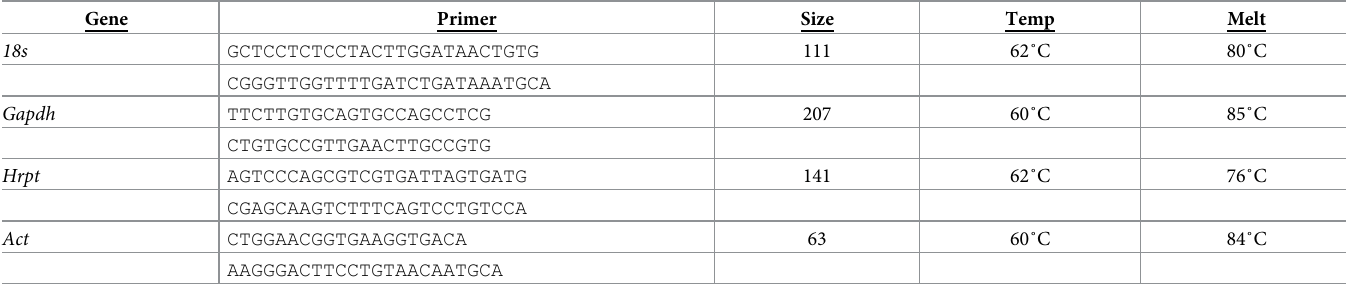
Table 1. Primer sequences and qPCR